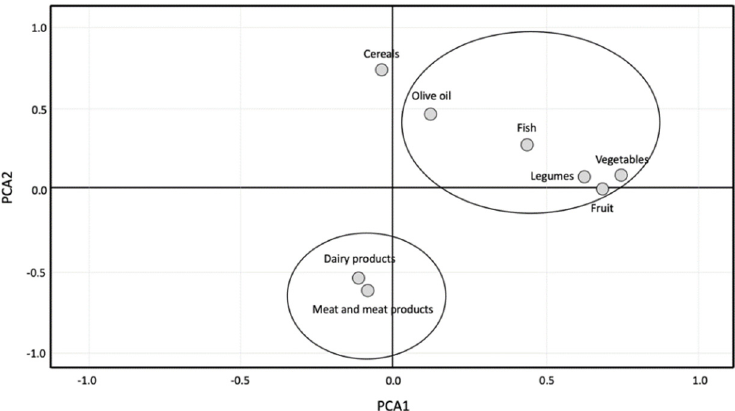
Figure 2. Principal component analysis of the individual food groups of the Medi-Lite score.